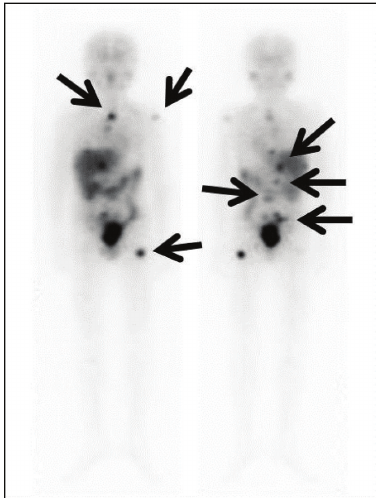
Figure 2: A 10-year-old male with relapsed neuroblastoma. He was treated with 16.8 mCi/kg I-131 MIBG. Multiple lymph nodes and bone metastases are detected by I-131 MIBG scintigraphy (arrows). After the treatment with chemotherapy and whole-body irradiation, he received CBSCT 4 weeks after the I-131 MIBG therapy. Complete remission has been maintained for more than 12